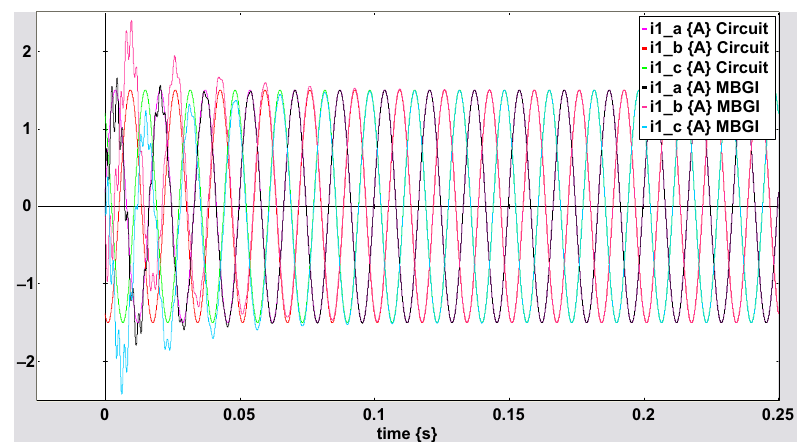
Figure A3. Three-phase current for i 1 using the equivalent reduced circuit and MBGI. The graphical behavior of the three-phase currents for i 2 is shown in Figure A4a,b, illustrating i 1 from the MBGI of Figure 12.